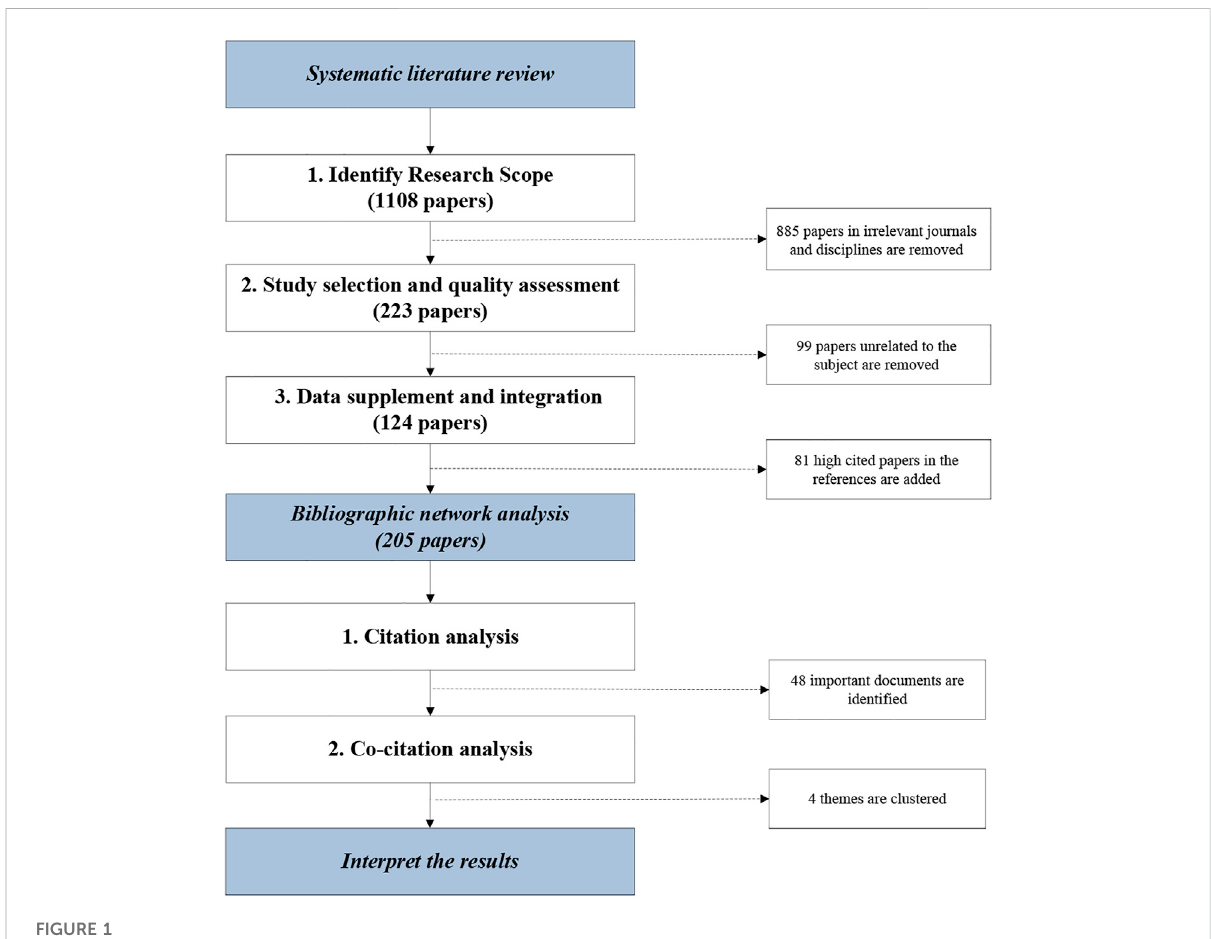
FIGURE 1 Research